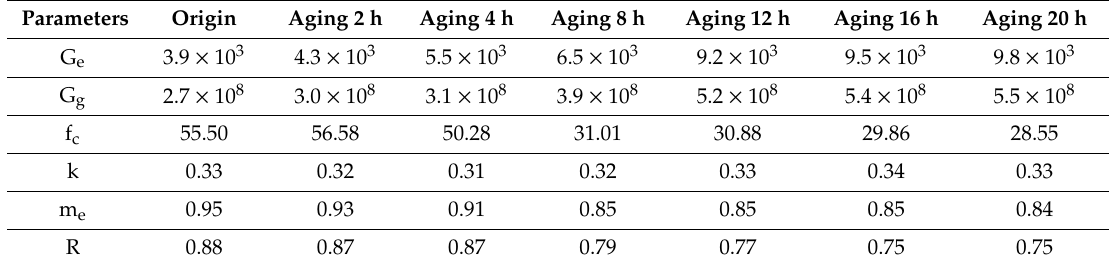
Table 4. CAM model fitting results of master-curves from mastics with di ff erent aging times.